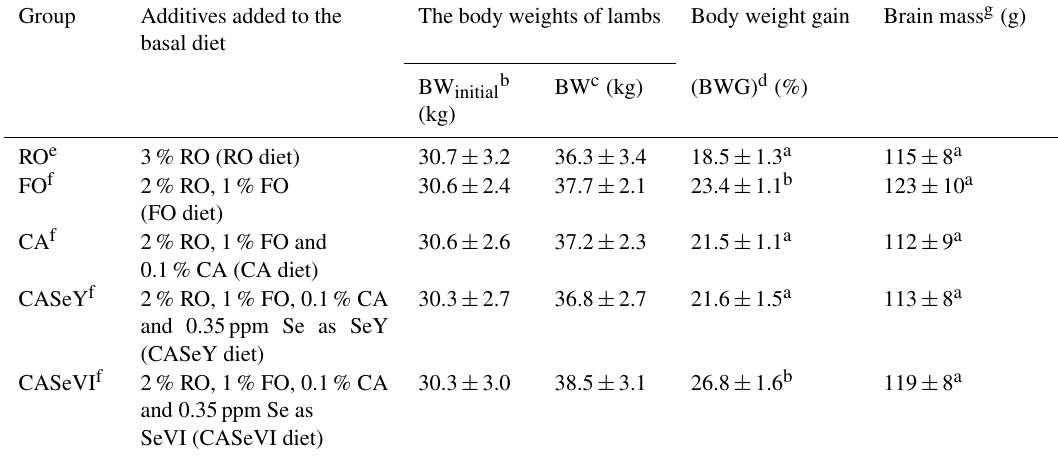
Table 2. The experimental scheme and the composition of the experimental diets, the body weight (BW) of lambs and brain masses a . Group Additives added to the The body weights of lambs Body weight gain Brain mass g basal diet